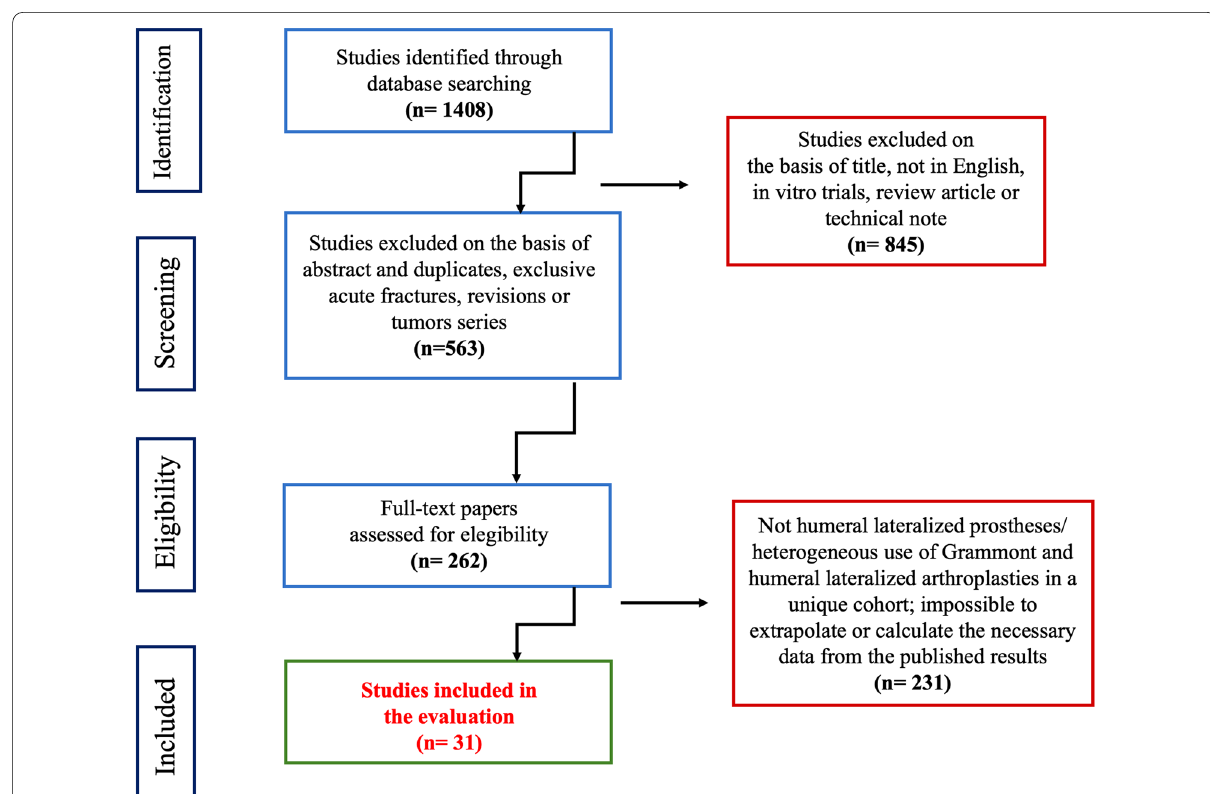
Fig. 1 Articles selection process of the